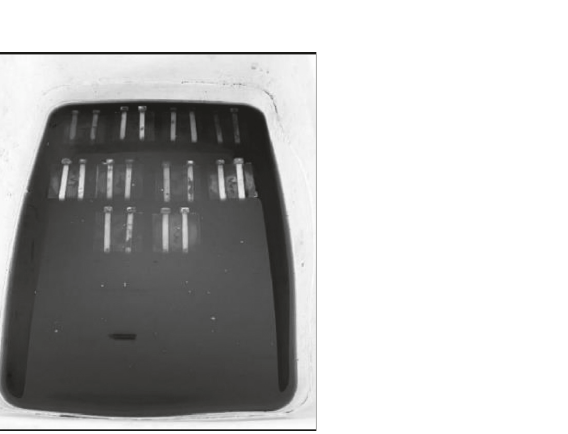
Figure 4: Immersion of samples in FA